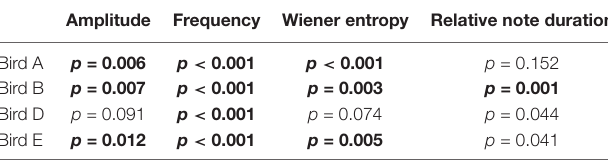
TABLE 3 | Statistics for adjacent-phrase vs. distant-phrase comparisons for birds A, B, D, and E. Amplitude Frequency Wiener entropy Relative note